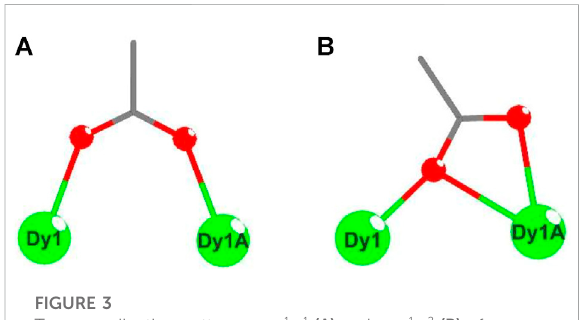
FIGURE 3 Two coordination patterns μ 2 : η 1 : η 1 (A) and μ 2 : η 1 : η 2 (B) of acetate groups in 1 .